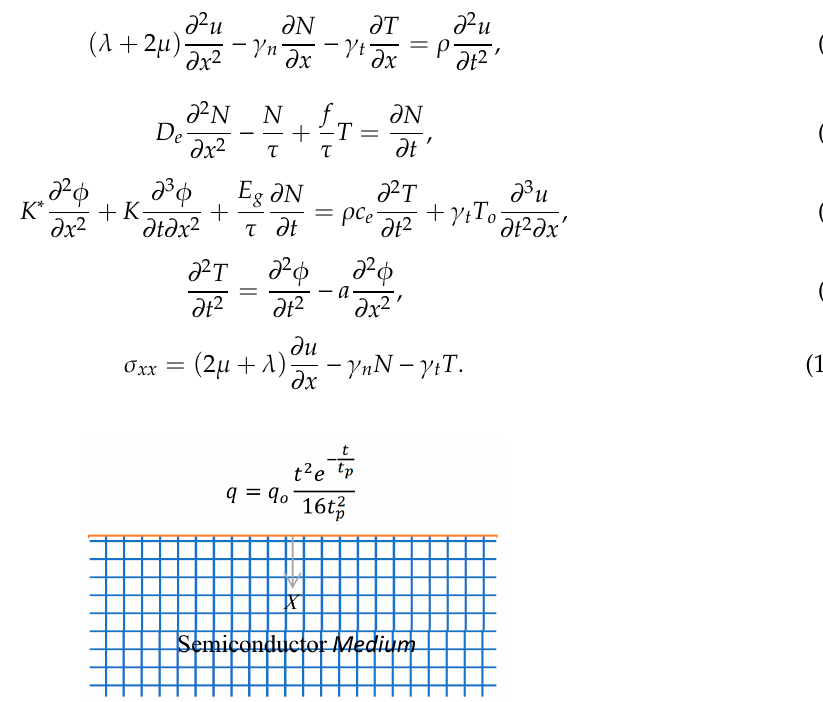
Figure 1. Schematic of the problem.